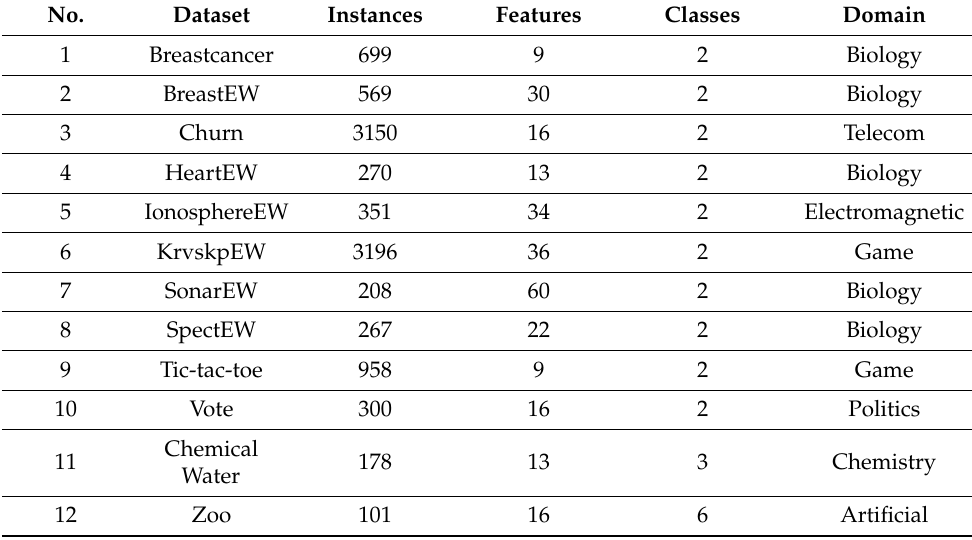
Table 1. List of the datasets used in the